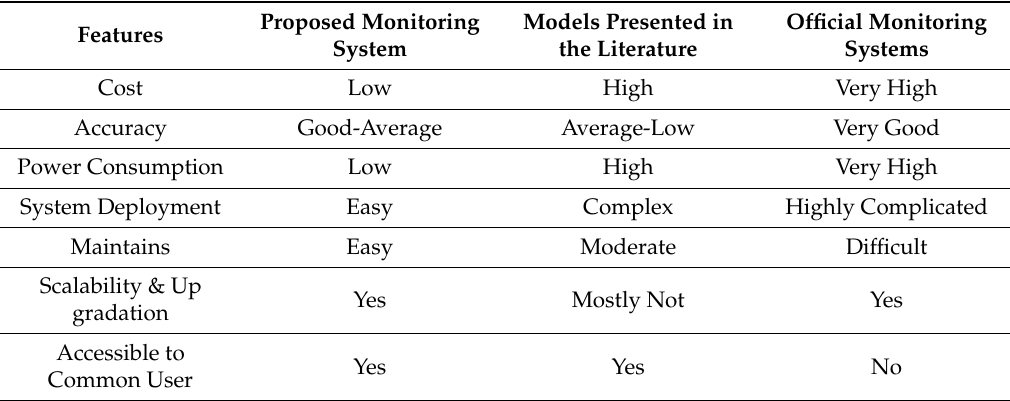
Table 3. Comparison of the proposed and the existing pollution monitoring systems.